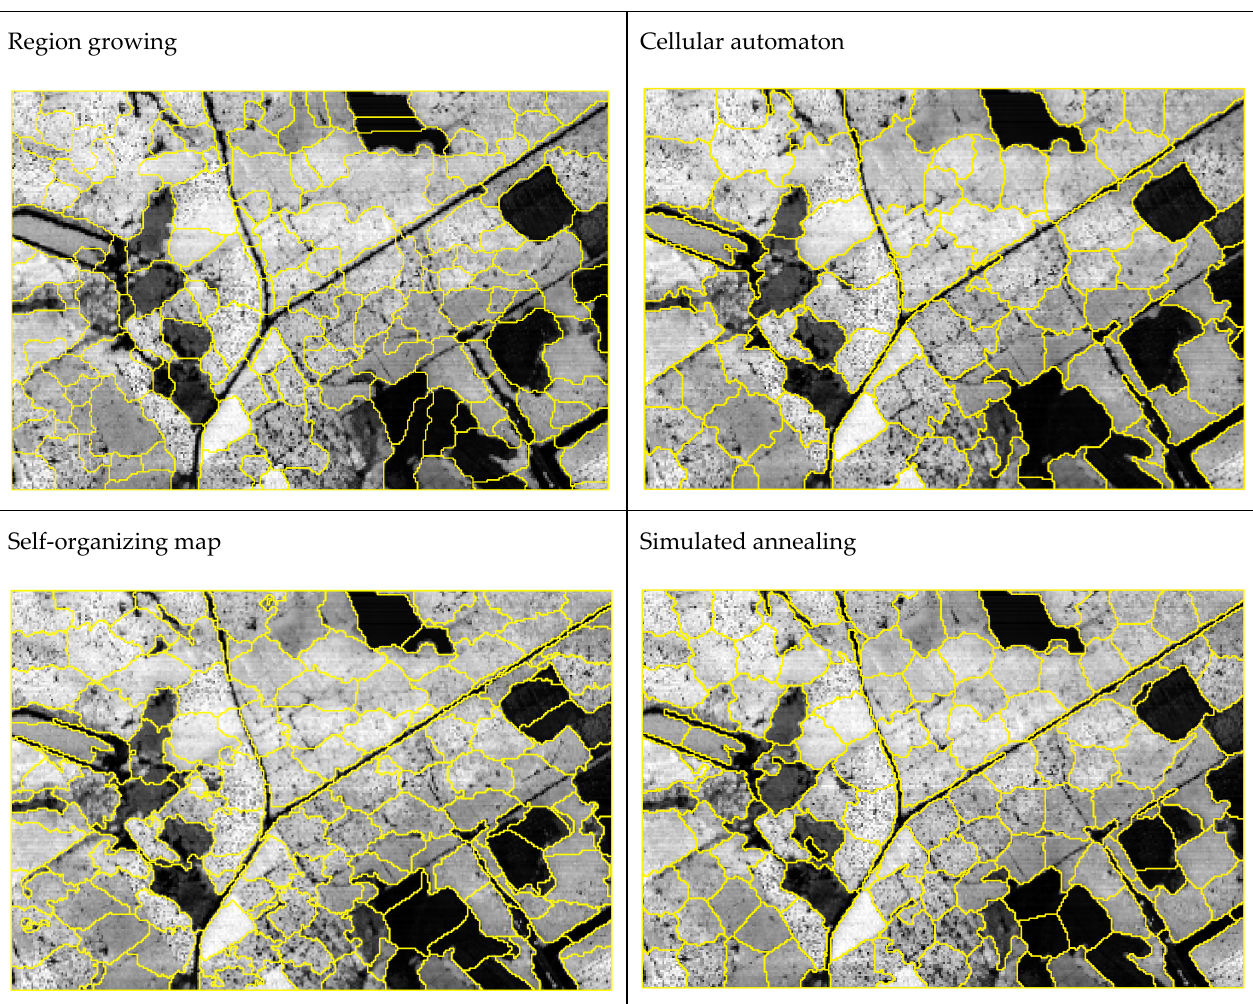
Figure 11. Segmentations produced by the four methods in case study area 3 (1.5 km × 1 km) overlaid with the 95th percentile of the height distribution of the echoes. Light tone indicates a high percentile value.